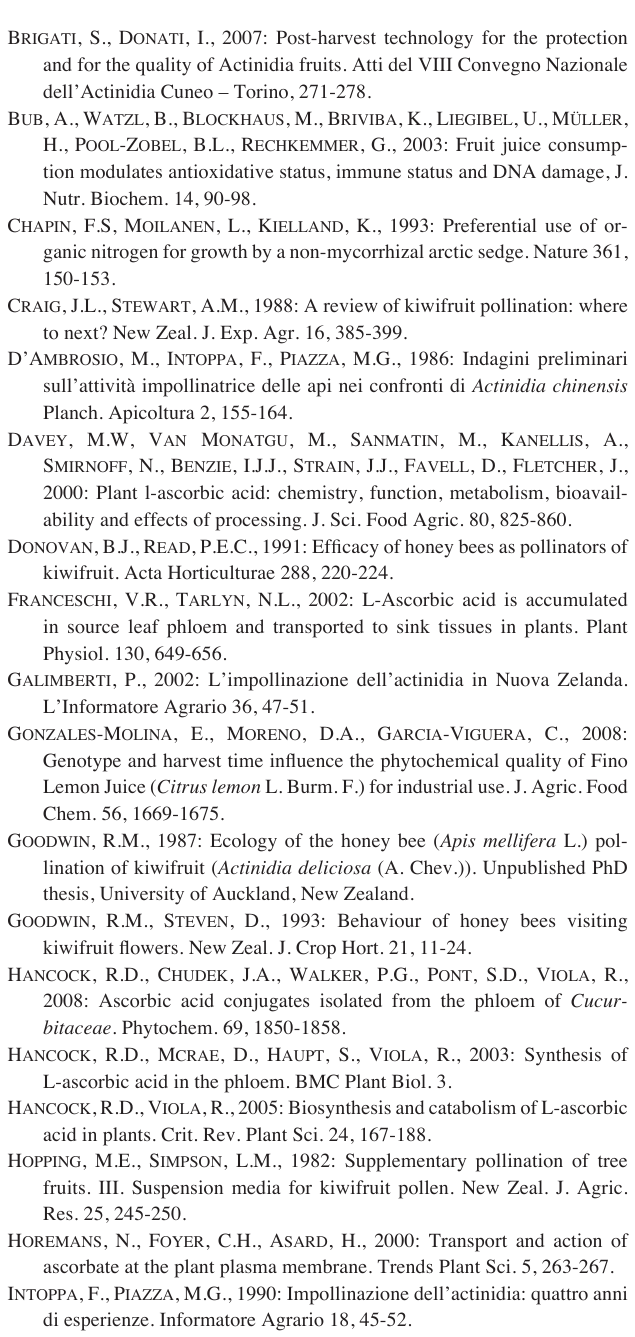
Fig. 1: HPLC separation of dehydroascorbic (DHAA) and ascorbic (AA)